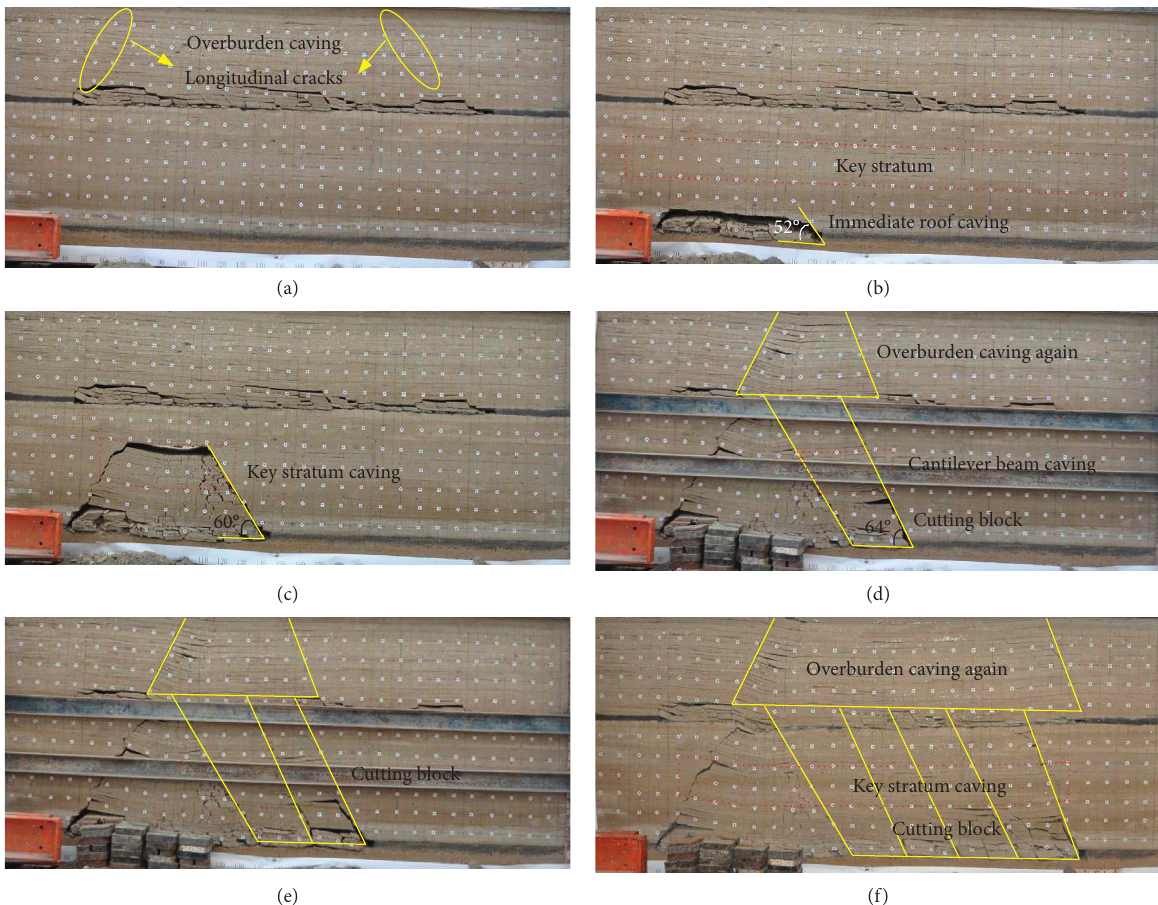
Figure 6: Overlying stratum breaking and instability in similar simulations: (a) extraction of the 2-2# coal seam completed; (b) extraction of the 4-2# coal seam at 85m; (c) extraction of the 4-2# coal seam at 100m; (d) extraction of the 4-2# coal seam at 130m; (e) extraction of the 4- 2# coal seam at 160 m; (f) completed extraction of the 4-2# coal